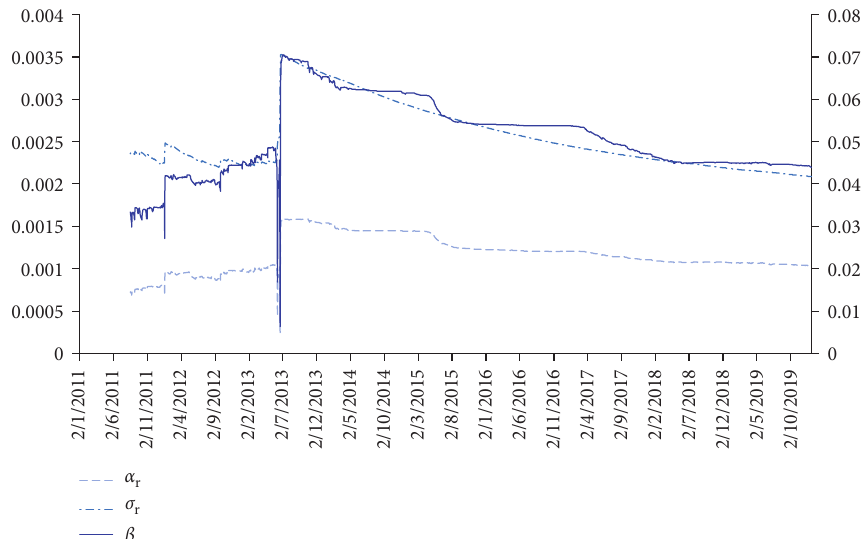
Figure 2: Changes of the parameters in the interest rate model from 2011 to 2020 (note: the value of β the remaining variables are the left-side primary